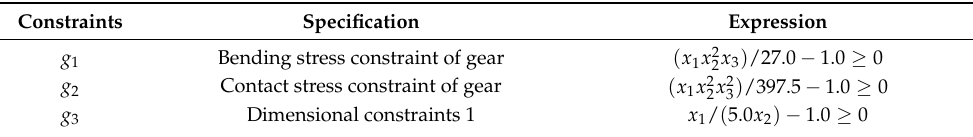
Table 2. The constraints of the speed reducer.